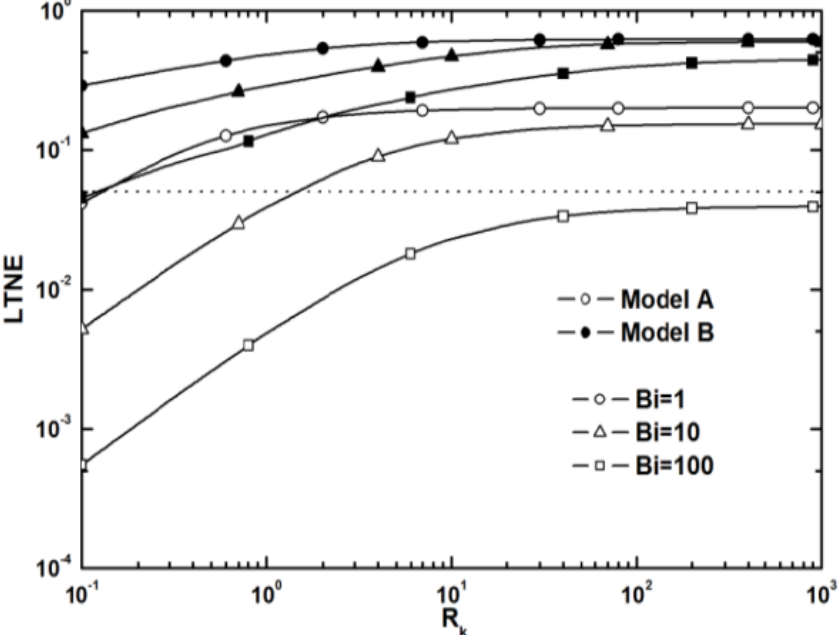
Figure 26. Profiles of LTNE parameter with solid/fluid thermal conductivity ratio, for various Biot numbers, presented by Abdedou and Bouhadef